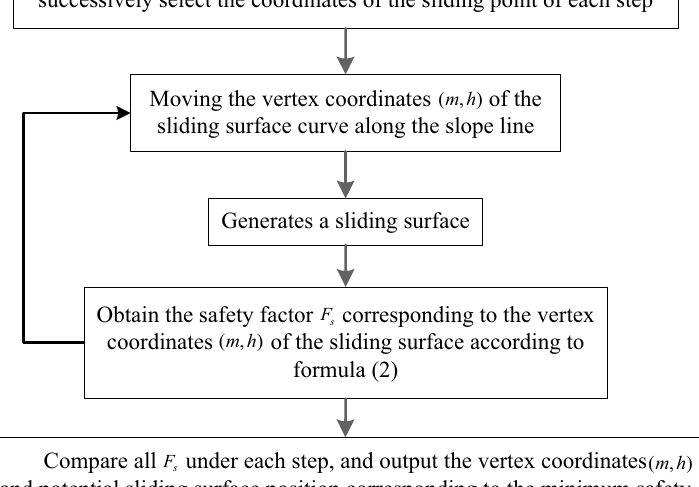
Figure. 4. Flowchart of sliding surface